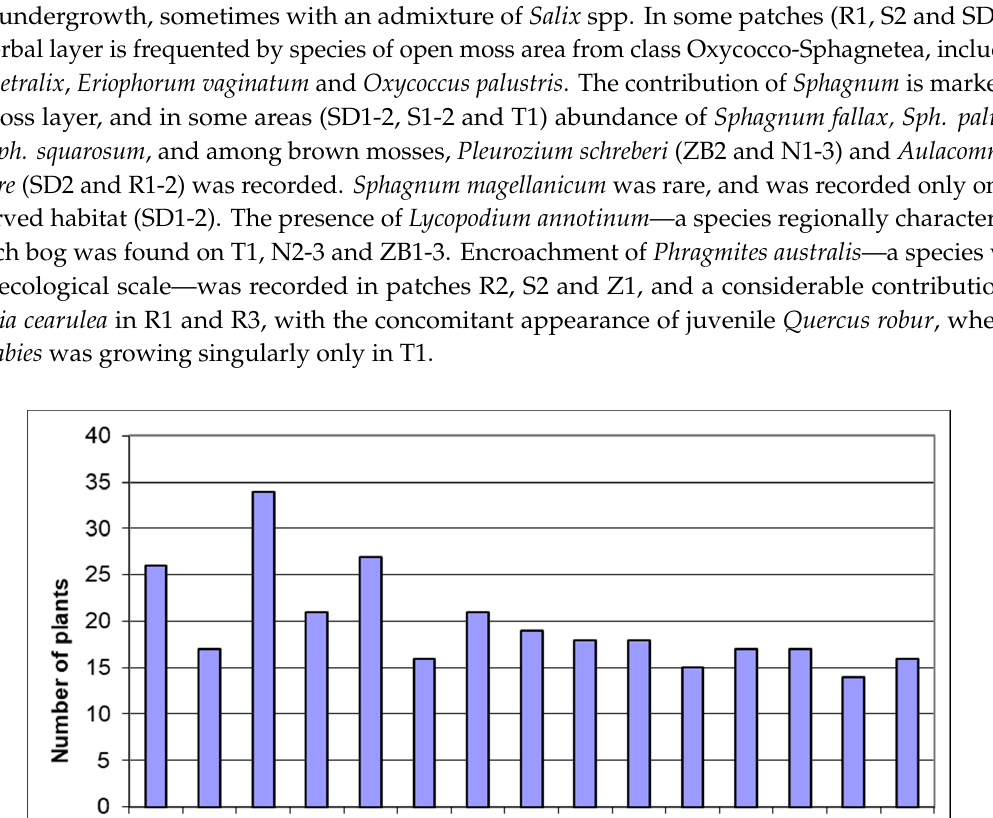
Figure 3. The vegetation cover in layers of the patches. Abbreviations: ‘a+b’—cover of tree and shrub layer, c—cover of herb layer, d—cover of moss layer.